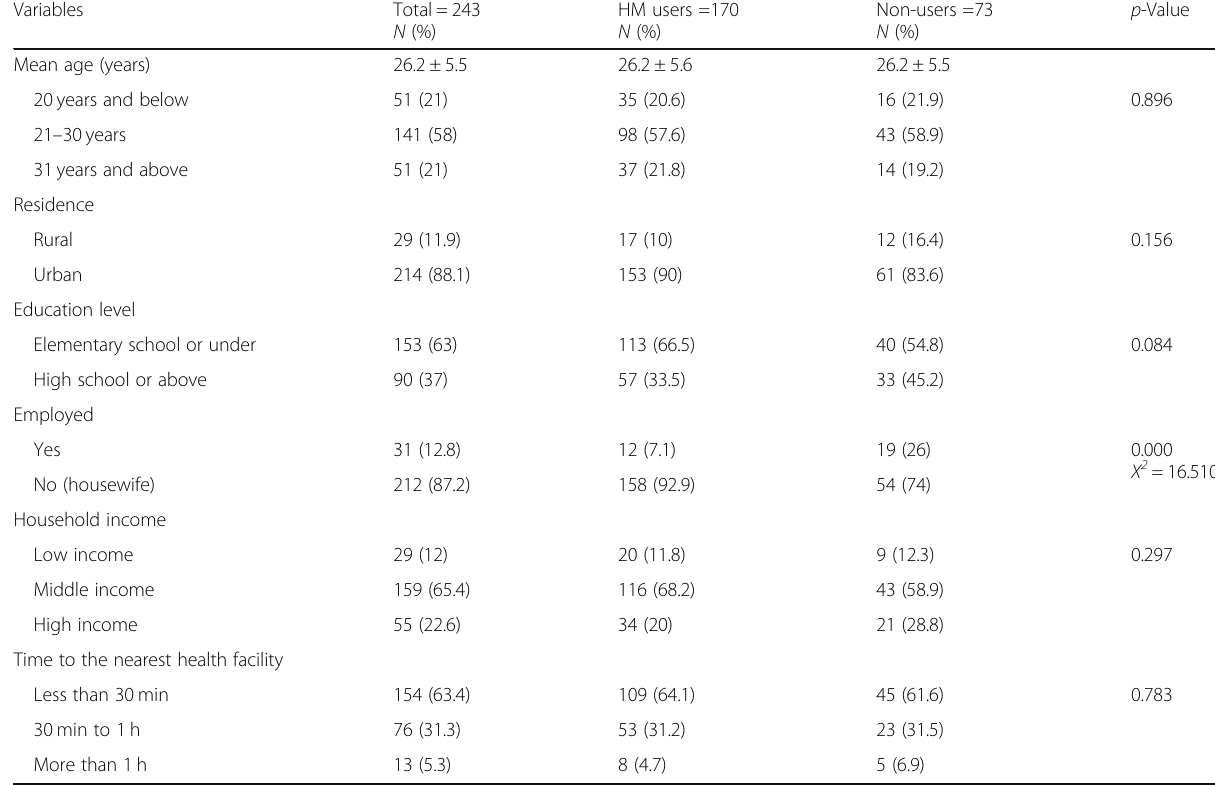
Table 1 Sociodemographic characteristics of participants